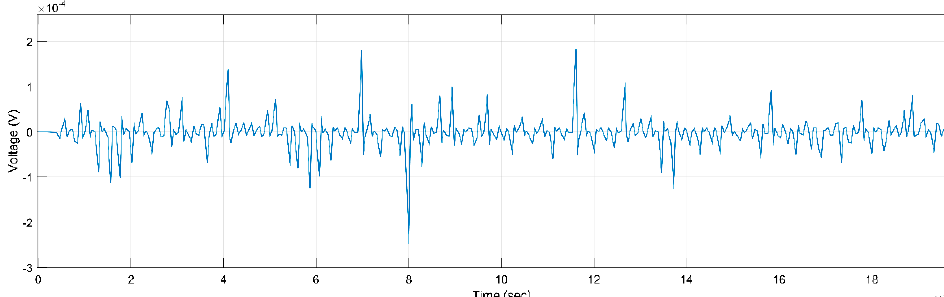
Figure 8. PD Activity for Mica, 15 kV, h, r.